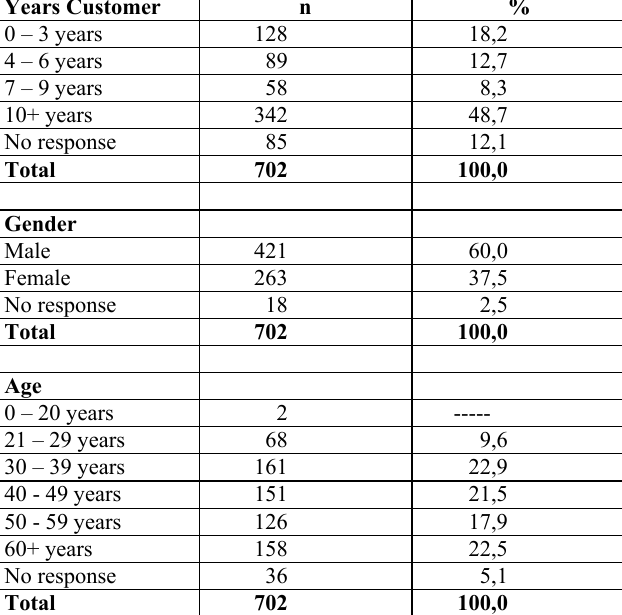
Table 1: The demographic composition of the realised